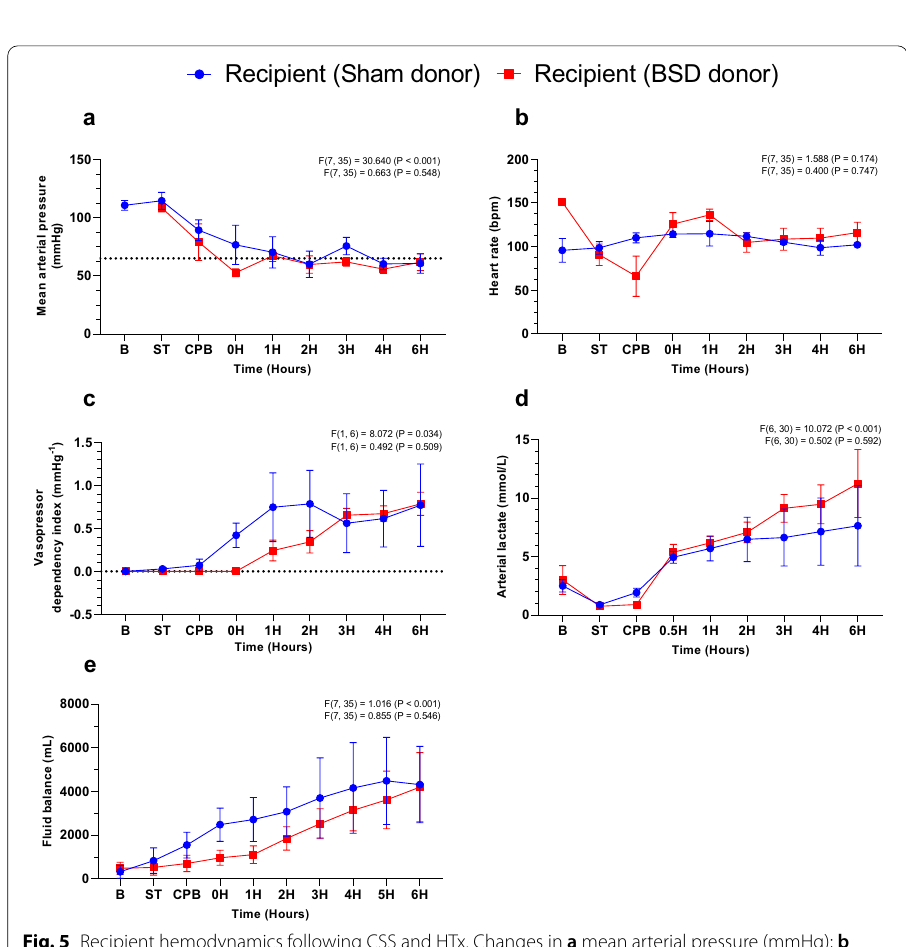
Fig. 5 Recipient hemodynamics following CSS and HTx. Changes in a mean arterial pressure (mmHg); b heart rate (bpm); c vasopressor dependency index (mmHg − 1 ); d arterial lactate (mmol/L); e fluid balance (mL) CSS and HTx. Data are expressed as mean SEM, n 4/group. Top F and p values on each graph represent ± = effect of time, and bottom F and p values represent differences between BSD vs. sham over time. B Baseline, ST stabilisation 1 h following completion of instrumentation procedures in recipient, CPB—establishment of cardiopulmonary bypass, 0H—successful weaning from